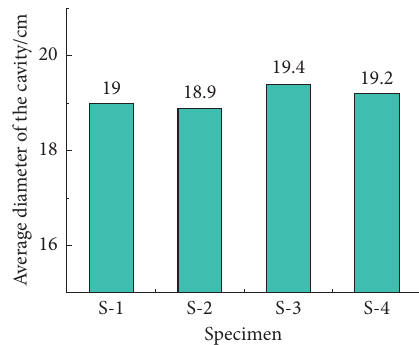
Figure 12: Average diameter of the specimen cavity.